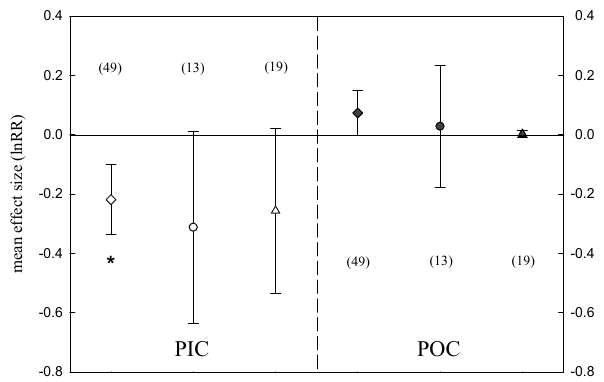
Figure 5. Comparison of effect sizes from PIC and POC anal- yses derived from the study by Kroeker et al. (2010, circles), Kroeker et al. (2013, triangles) and the present study (diamonds). Data from Kroeker et al. (2010 and 2013) were extracted di- rectly out of the study with the help of the Web Plot Digi- tizer Software (www.arohatgi.info/WebPlotDigitizer/). The meta- analysis from the present study contains experiments of all coccol- ithophore species, including those of Calcidiscus leptoporus (see Table 2). Error bars denote the 95% confidence intervals. * indi- cates a significant response, which is given when the confidence interval does not overlap zero. The number of experiments included in the meta-analysis is shown in parentheses. The zero line indicates no